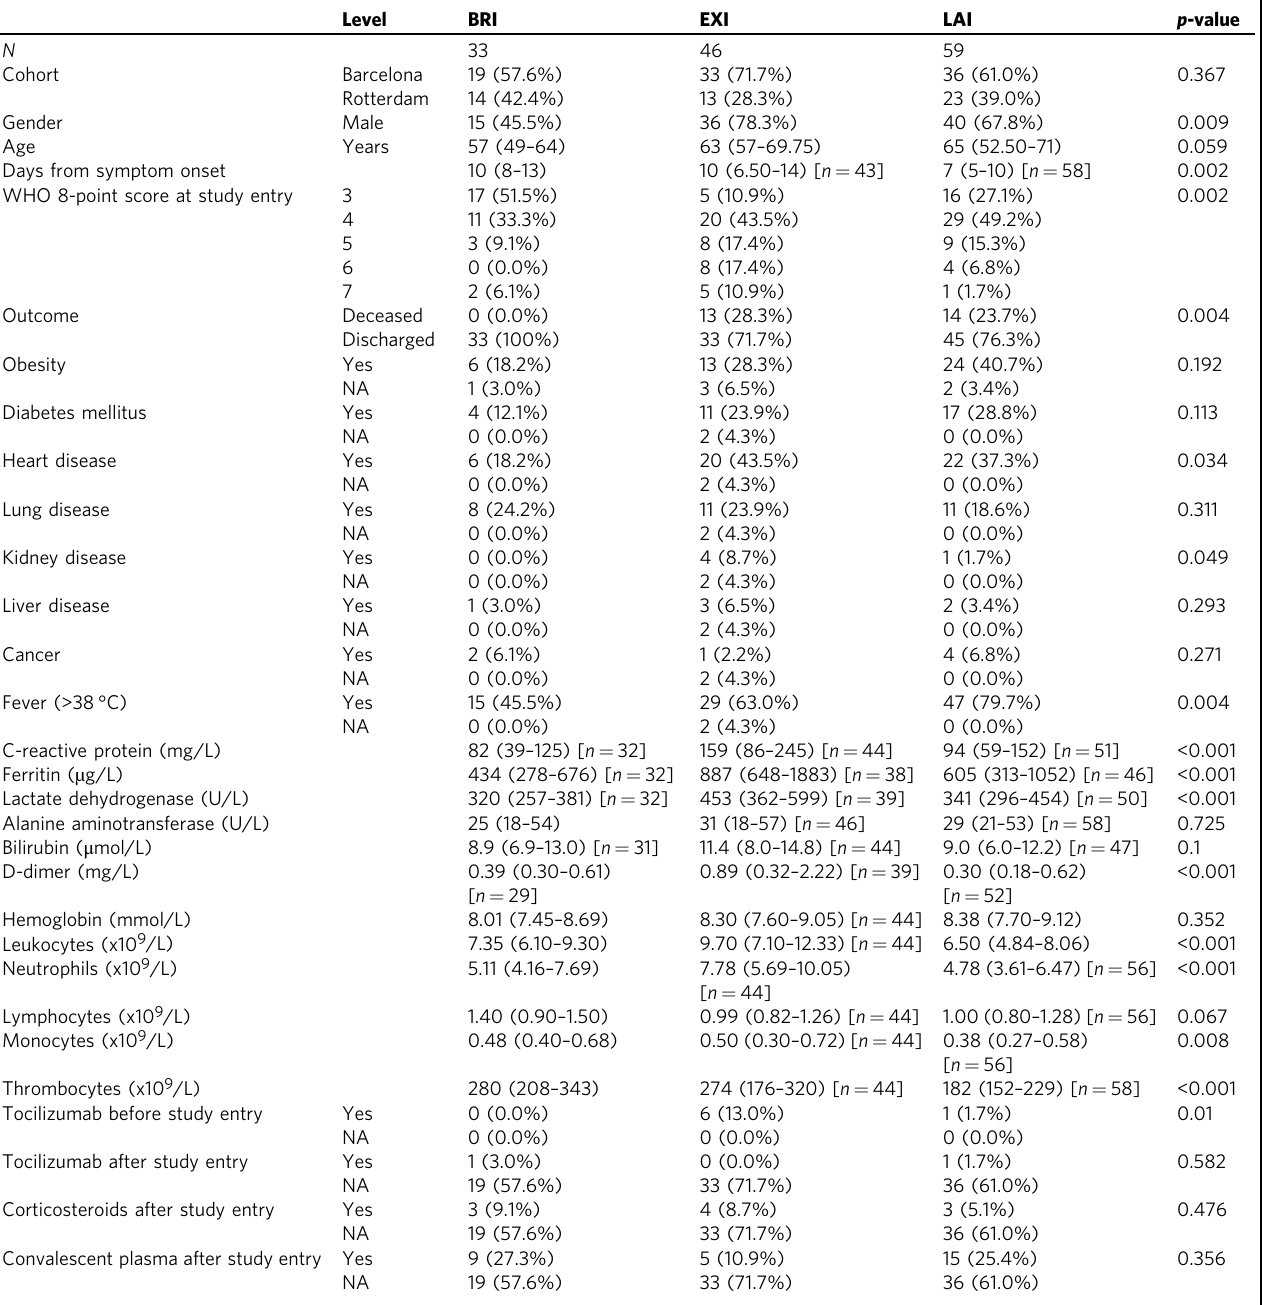
Table 2 Clinical and laboratory characteristics of BRI, EXI and LAI immunotypes.